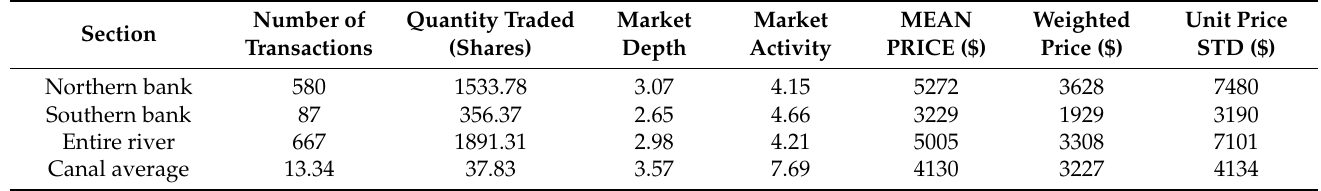
Table 2. Ñuble River WUR market study. Number of transactions, quantity traded (shares), market depth and activity, mean price, weighted price and standard deviation of Ñuble River WUR separated by section